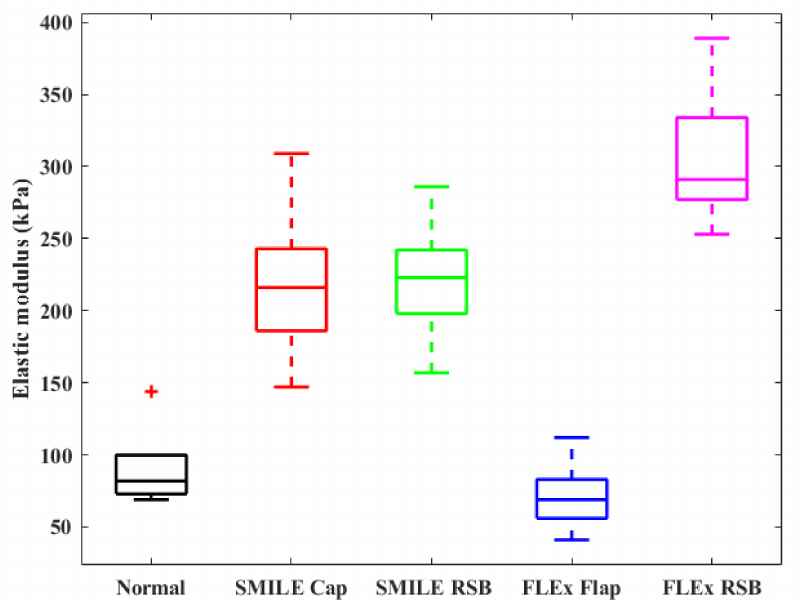
Figure 7. Elastic modulus statistical results of the normal cornea, corneal cap/fap and RSB before and after FLEx and SMILE